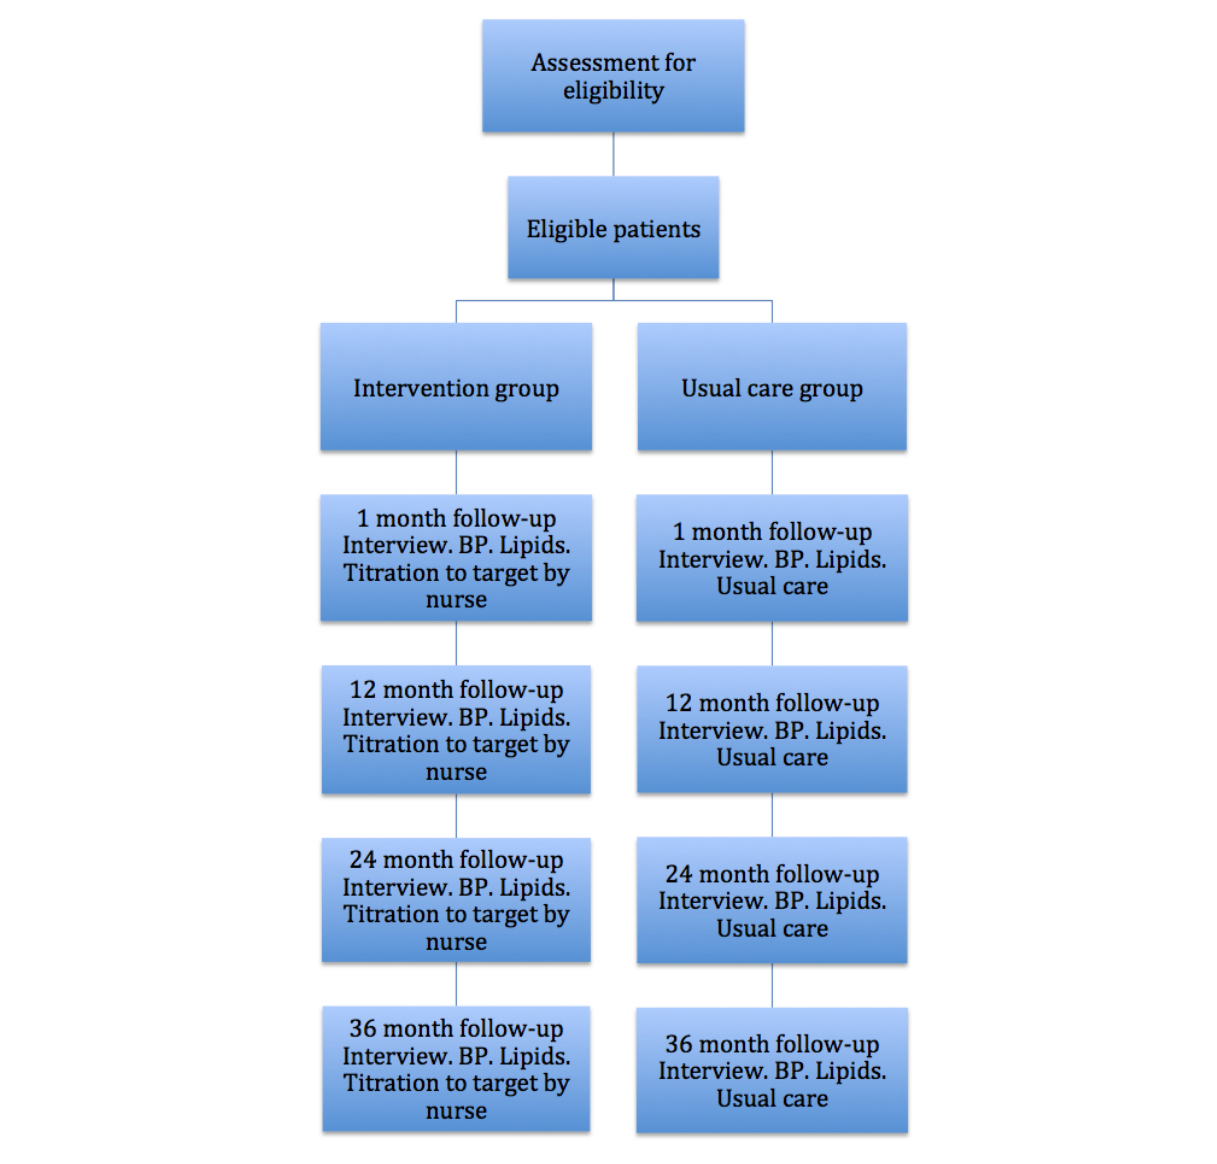
Figure 1. Study flow chart (BP=blood